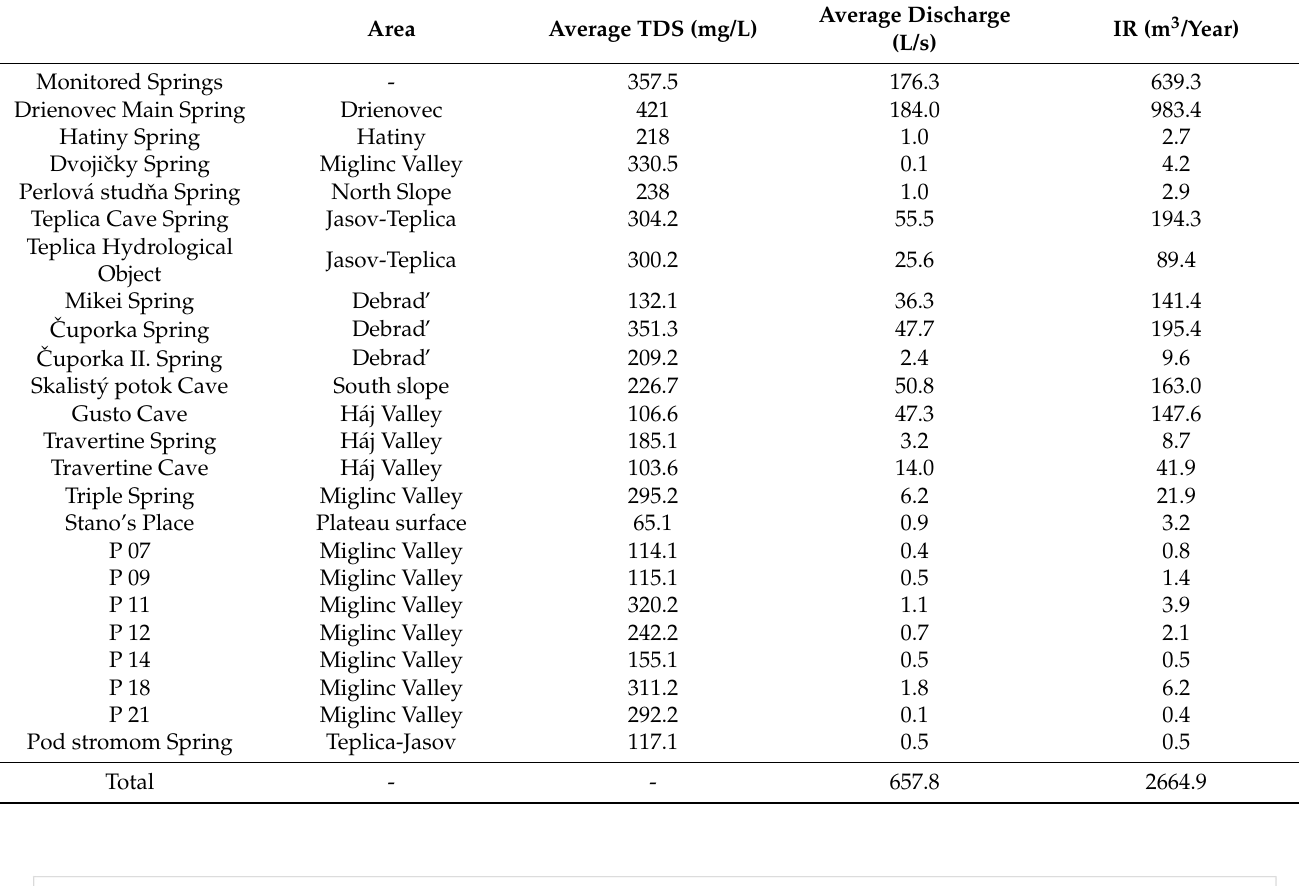
Table 1. Average discharge, TDS and ionic runoff overview based on measurements and available data.